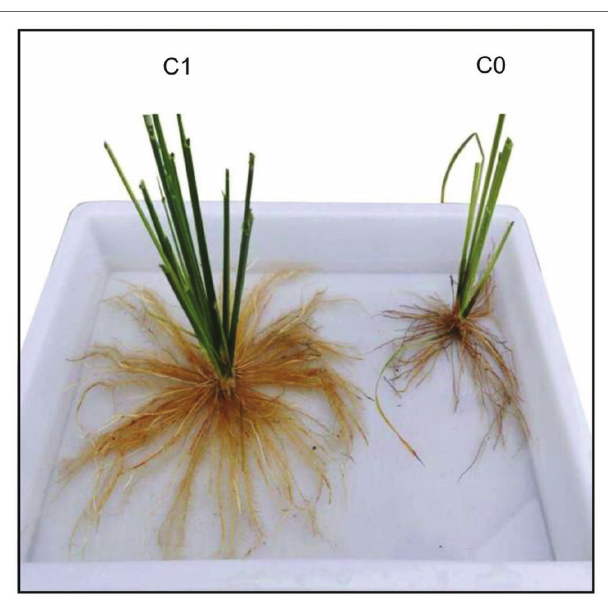
FIGURE 8 | Comparison on roots of rice plants grown with biochar application (C1) and without biochar application (C0).